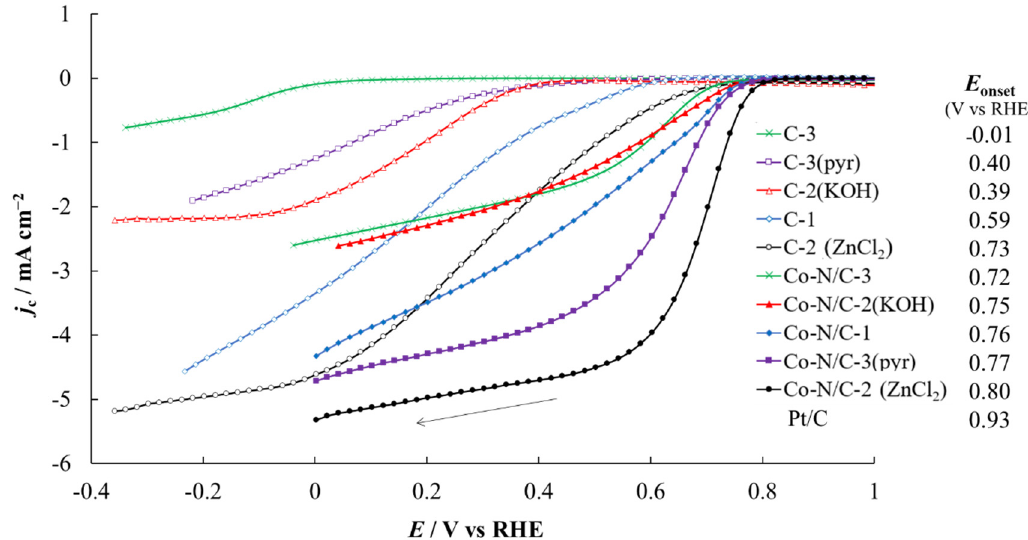
Figure 8. ORR curves (background and iR-corrected) for the studied materials (noted in Figure) in 0.1 M HClO 4 solution at 2000 rpm and 10 mV s − 1 .